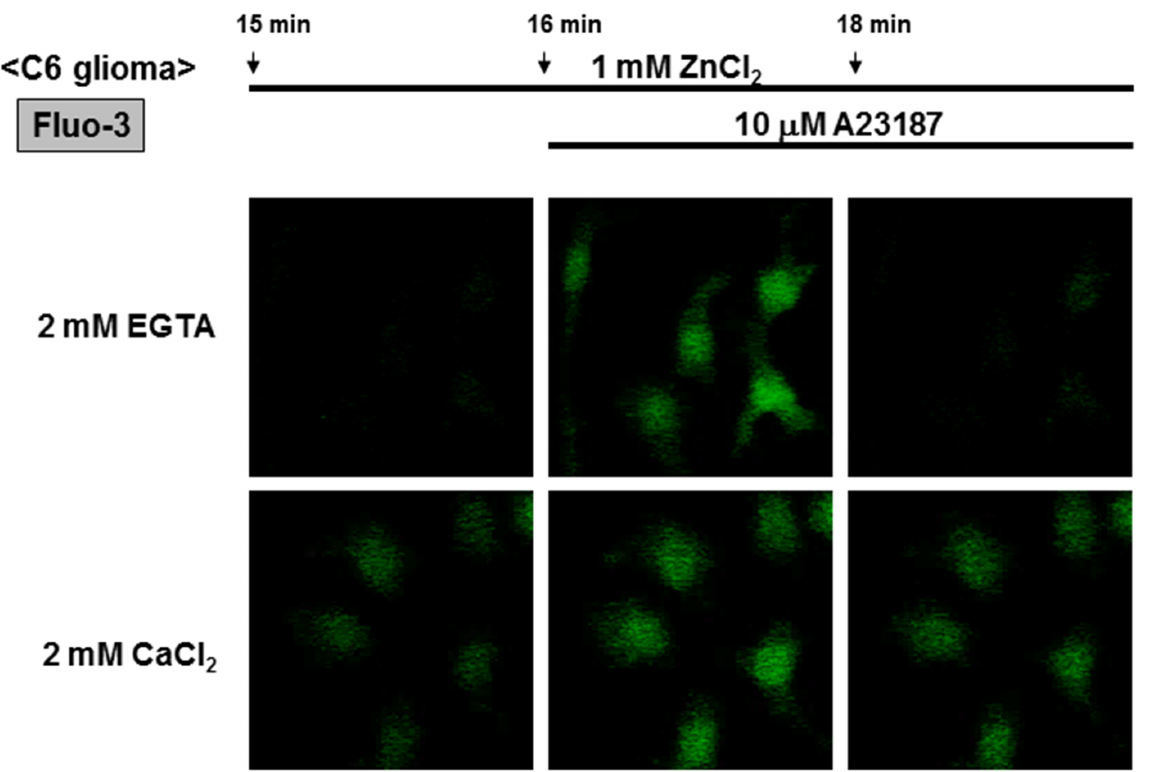
Fig 4. Micrographic pictures of Fluo-3 fluorescence in C6 glioma cells exposed to CaCl 2 and ZnCl 2 in the presence of A23187 and EGTA. Typical pictures are shown here.